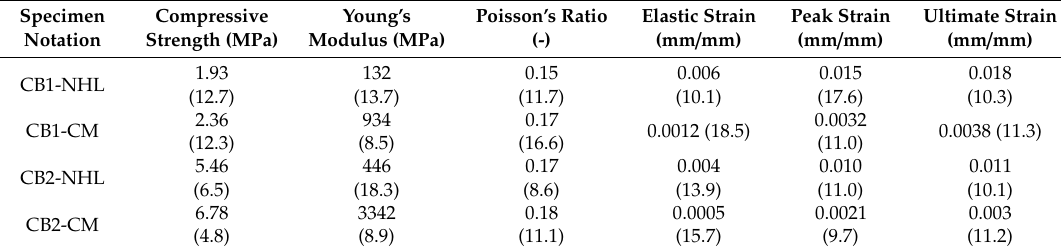
Table 7. Cyclic compressive strength and deformation